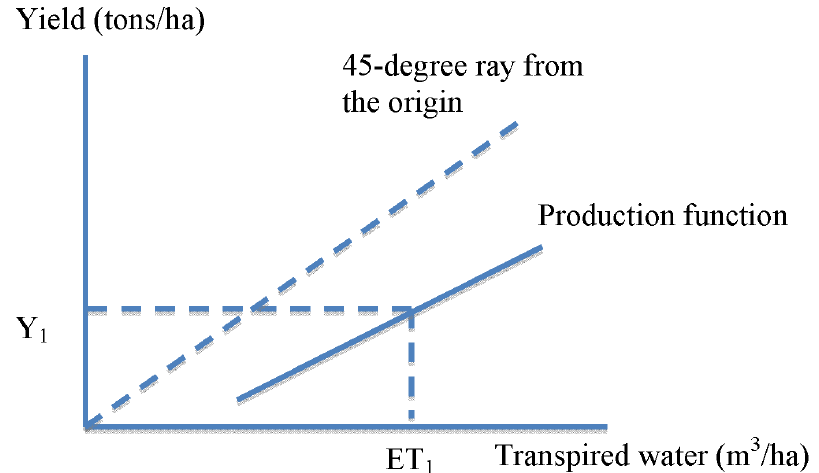
Figure 5. Depicting crop water productivity of evapotranspired water, when the linear segment projects a negative vertical axis